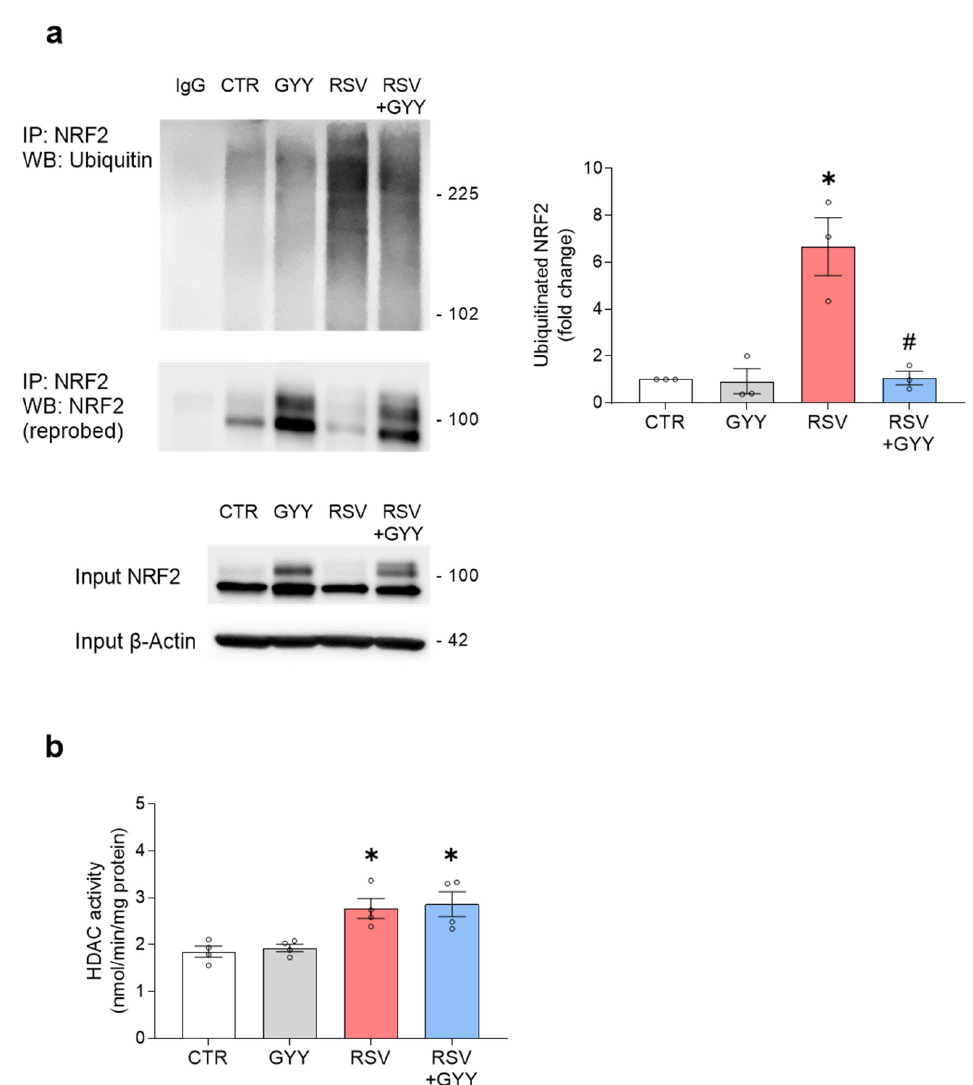
Figure 4. H 2 S donor GYY4137 restores NRF2 ubiquitination and does not affect histone deacetylase (HDAC) activity in RSV infection. ( a ) SAECs uninfected and infected with RSV were treated with 5 mM GYY4137 and harvested 18 hpi. NRF2 was immunoprecipitated from total cell lysates with anti-NRF2 antibody and NRF2 ubiquitination was analyzed by Western blot with anti-ubiquitin antibody. The membrane was stripped and reprobed with anti-NRF2 antibody to determine levels of immunoprecipitated NRF2. A sample of the original pre-immunoprecipitation lysate was also analyzed by Western blot to show levels of NRF2 before immunoprecipitation (input). Western blot ysis of NRF2 ubiquitination after normalization to immunoprecipitated NRF2 expressed as mean ±